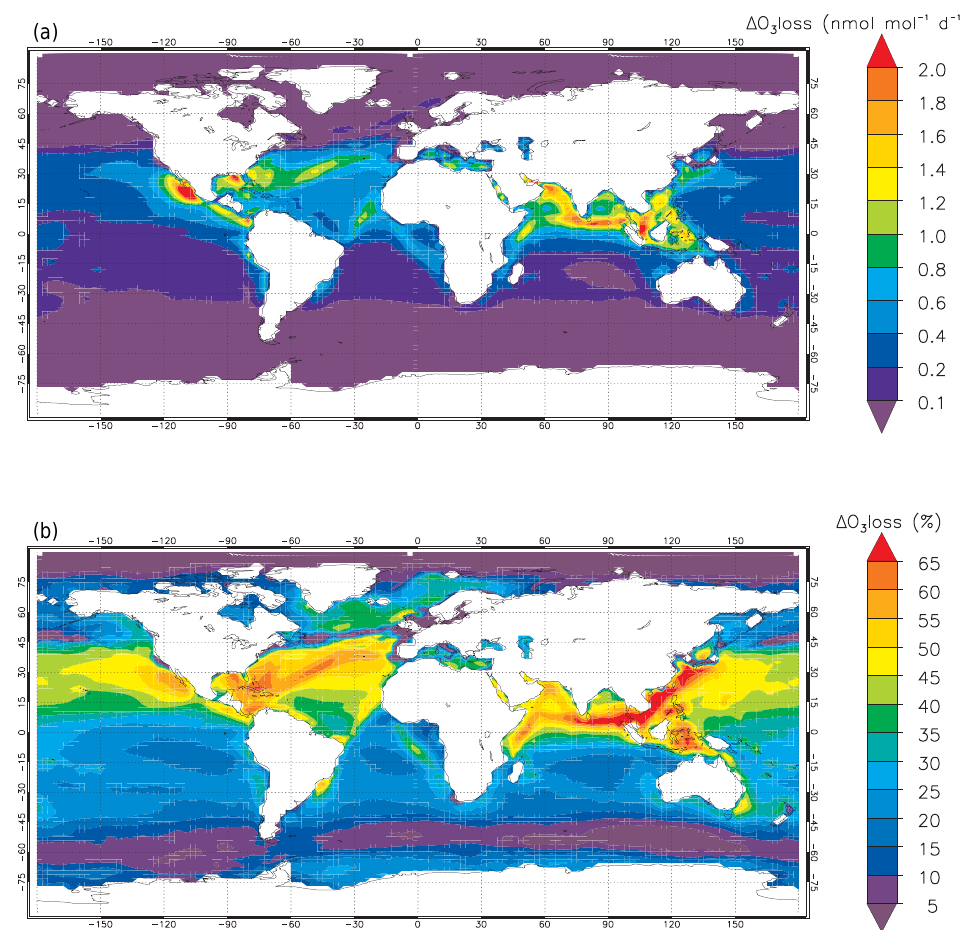
Figure 7. Geographical distribution of the annual acceleration of the ozone chemical loss rate by iodine in the MBL: (a) absolute acceleration (PD-PI); (b) percentage acceleration, i.e. 100 ×